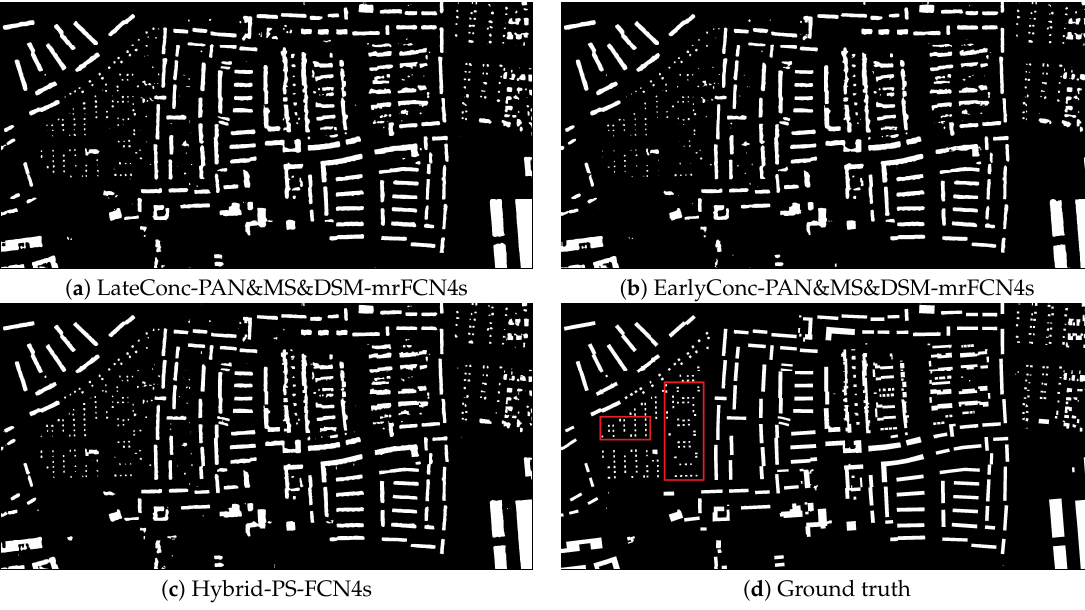
Figure 7. Generated masks of three different fusion